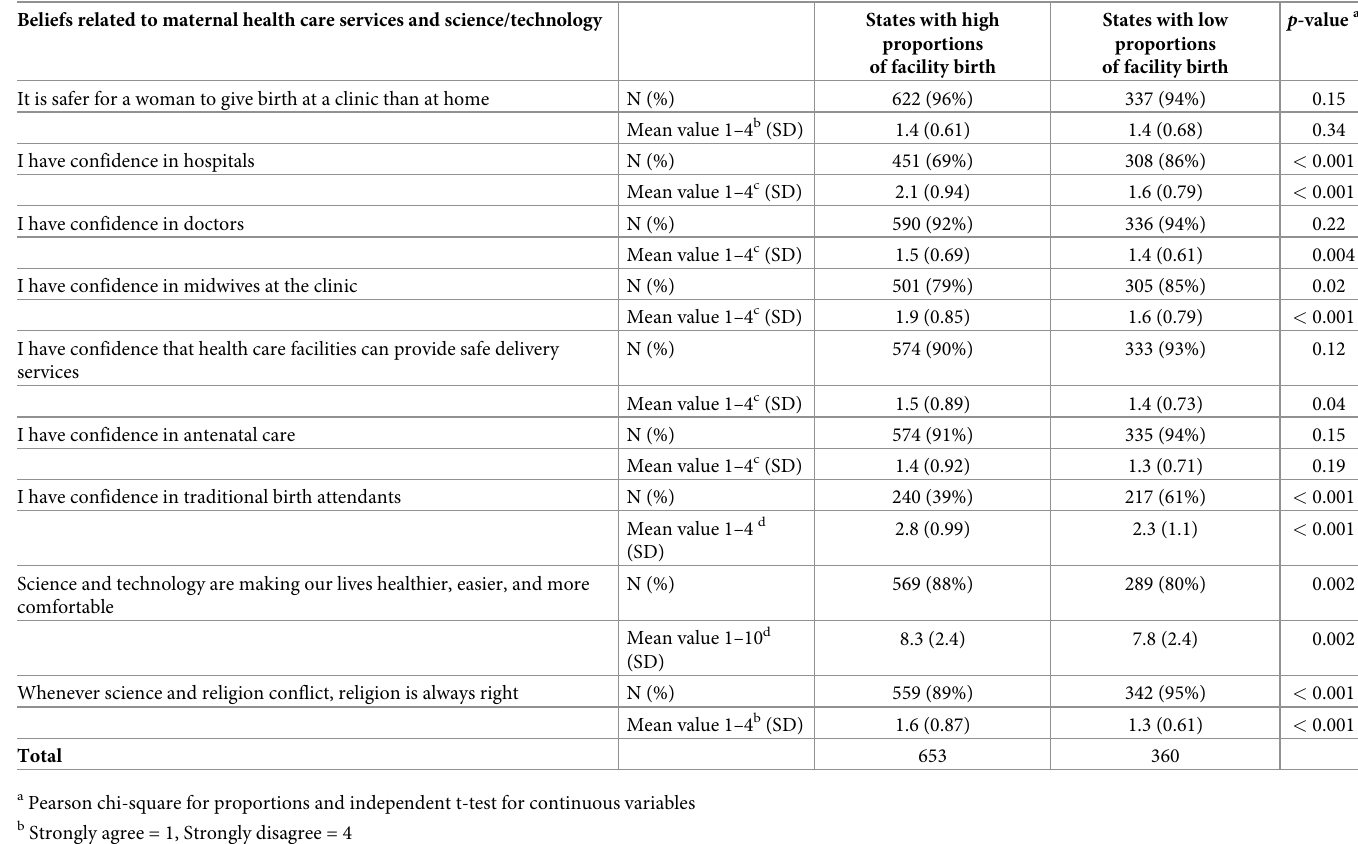
Table 3. Beliefs related to maternal health care services and science/technology in